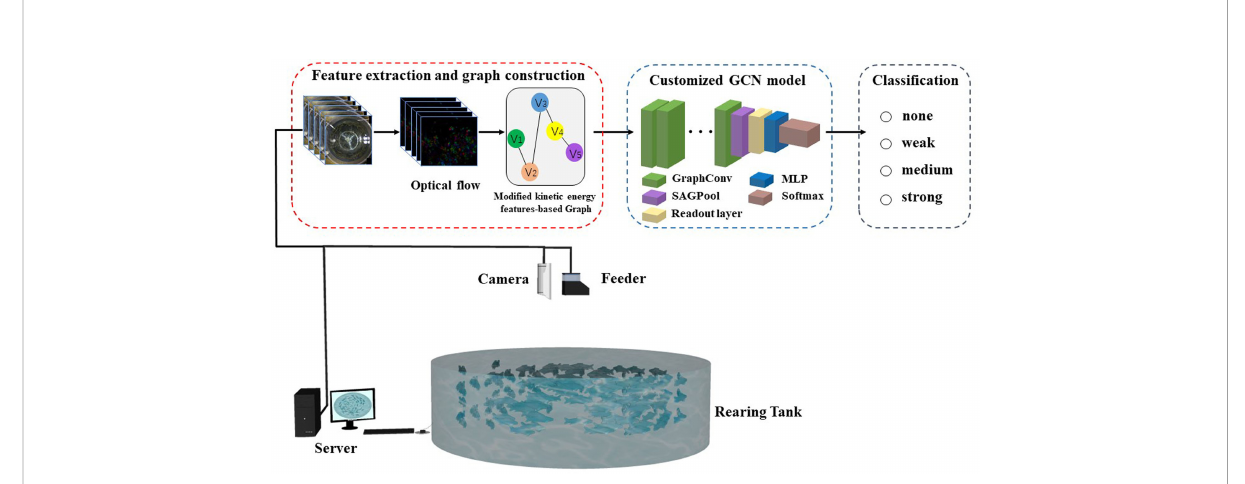
FIGURE 1 The overview of the fi sh appetite grading